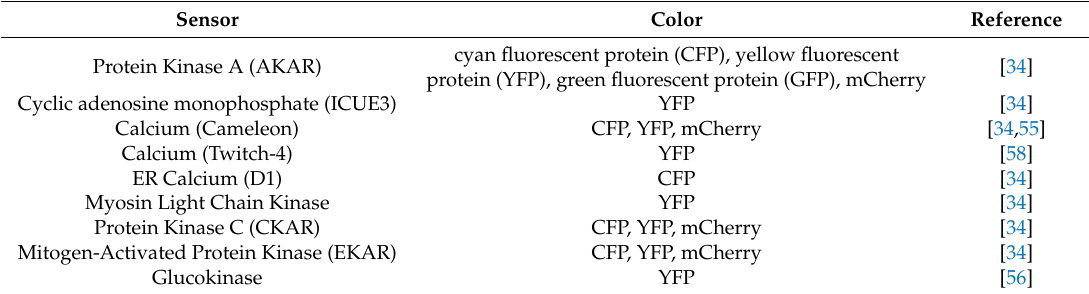
Table 1. Double-fluorescent protein homotransfer